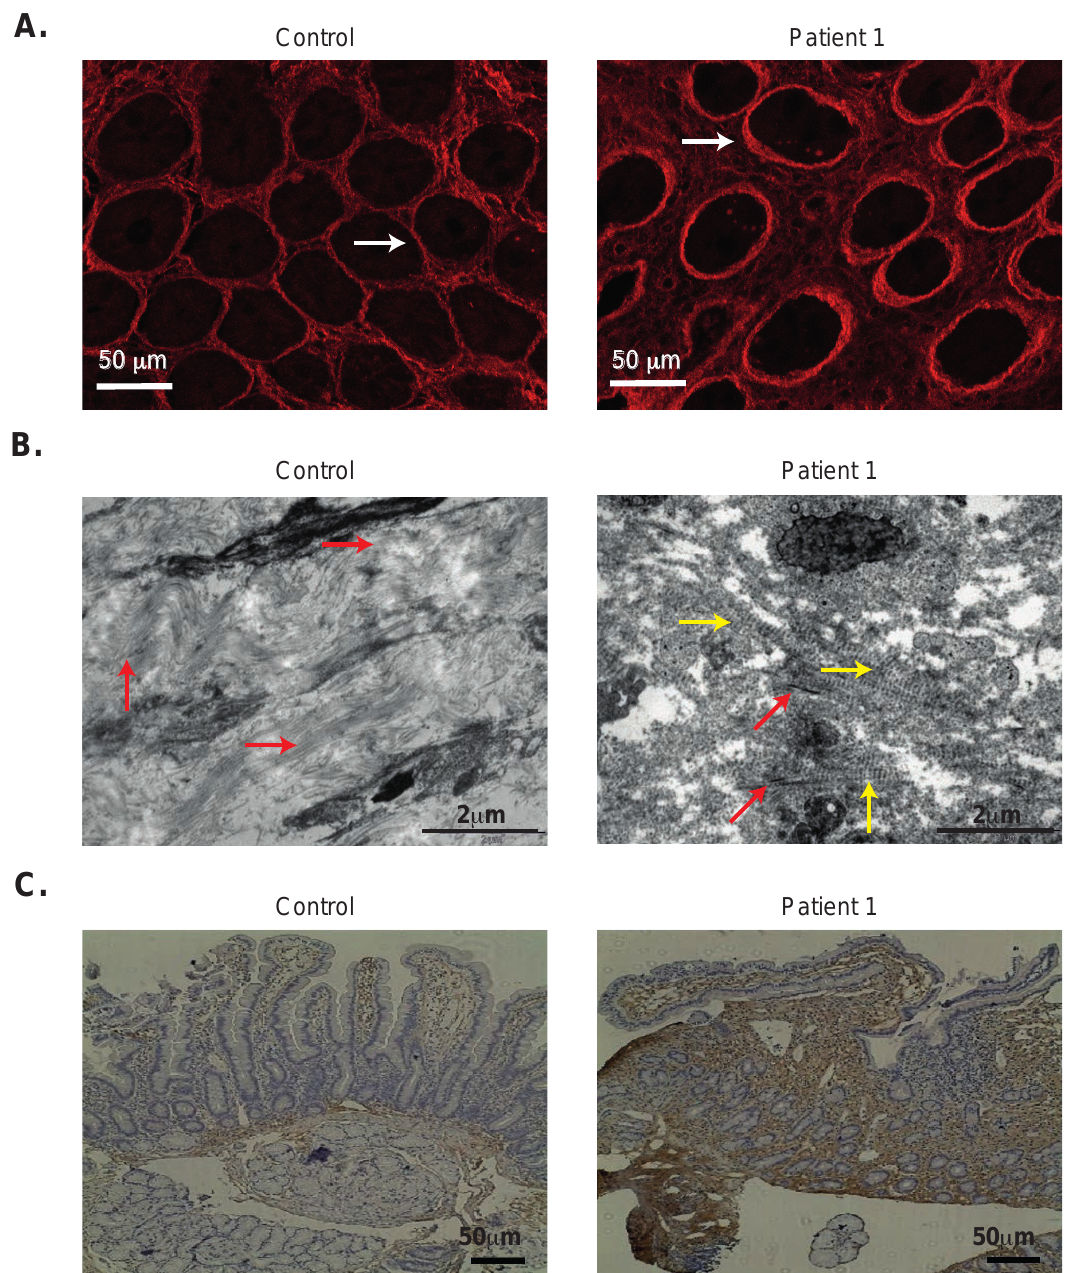
Figure 6. Abnormal extracellular matrix morphology in duodenum of ANTXR2-deficient patients. ( A ) Second harmonic generation imaging of duodenal FFPE samples. Red signifies collagen. White arrows point to crypt wall. ( B ) Duodenal electron microscopy images ( × 15,000) from control subject (infant evaluated for chronic diarrhea) and Patient 1. Red arrows point to collagen I and yellow arrows point to collagen VI. ( C ) Collagen VI staining (brown colored) in duodenal